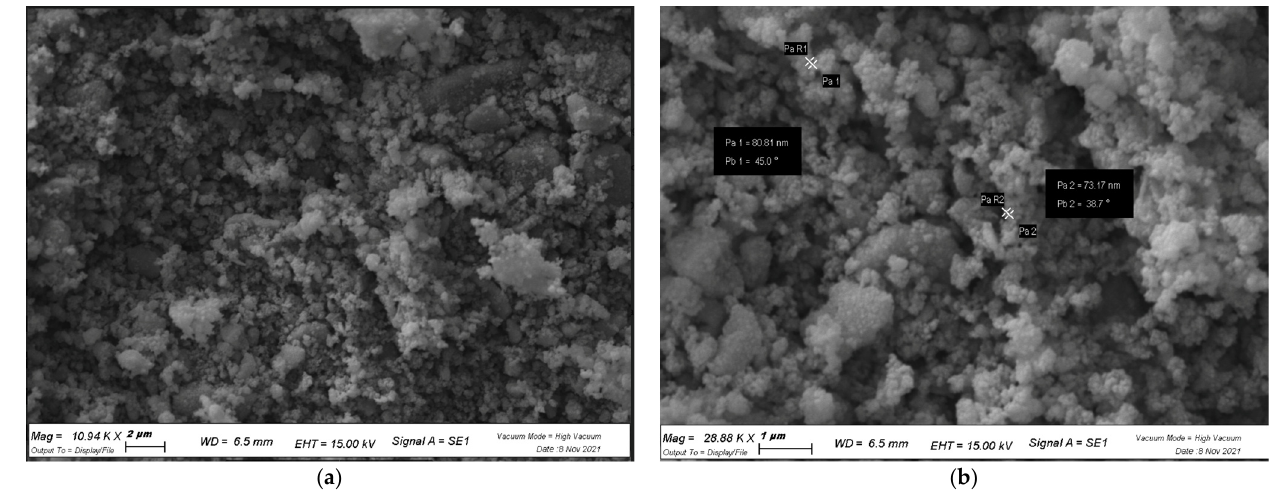
Figure 5. SEM image of Zinc Oxide, Stearic Acid at different magnifications. ( a ) 10,900× magnifica- tion; ( b ) 28,880× magnification.